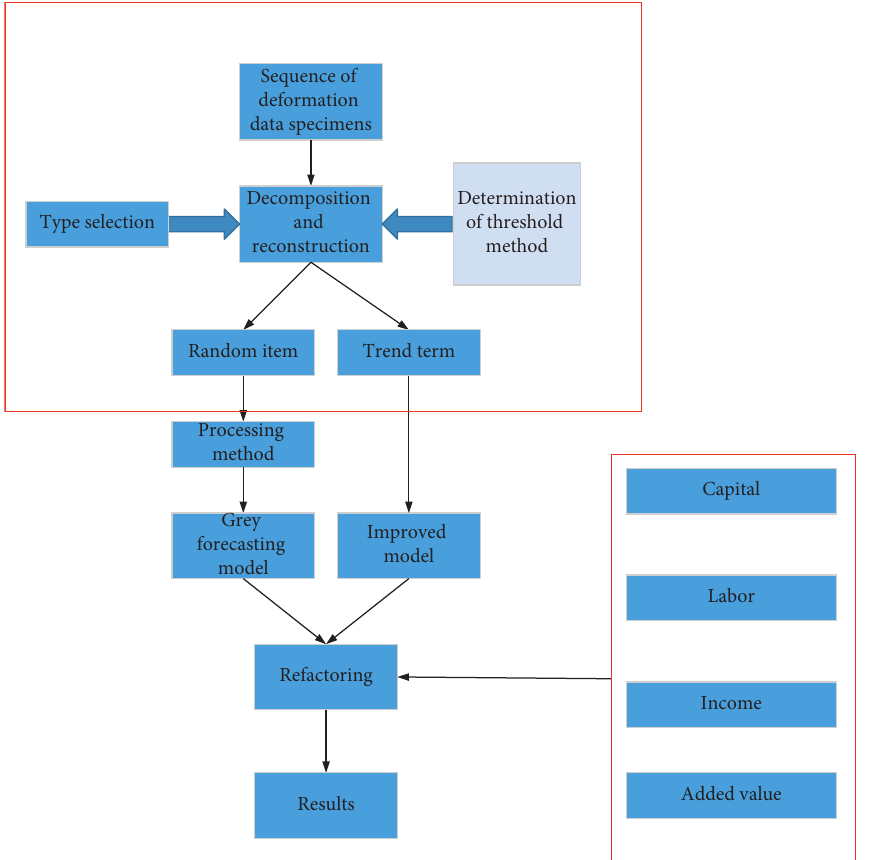
Figure 9: Tourism and revenue